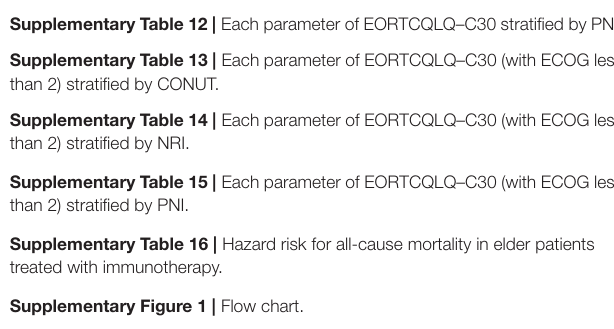
Supplementary Table 1 | Procedures for the evaluation of each nutritional index. Supplementary Table 2 | Baseline Characteristics of the Study Population stratified by CONUT. Supplementary Table 3 | Baseline Characteristics of the Study Population stratified by NRI. Supplementary Table 4 | Baseline Characteristics of the Study Population stratified by PNI. Supplementary Table 5 | Kappa agreement for CONUT, PNI, NRI index.